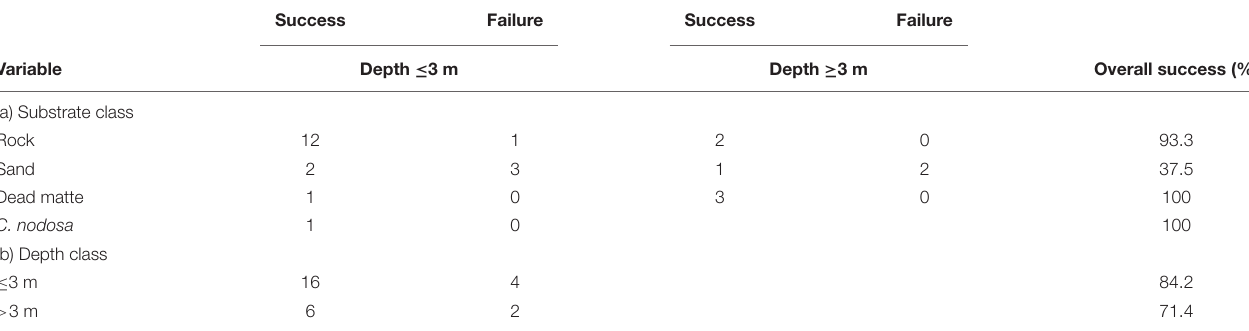
TABLE 2 | Chance of colonization success by P. oceanica seedlings: total number of successes or failures and overall frequency of success (%) of colonization classified according to (a) habitat type (substrate class) and depth class and (b) depth class